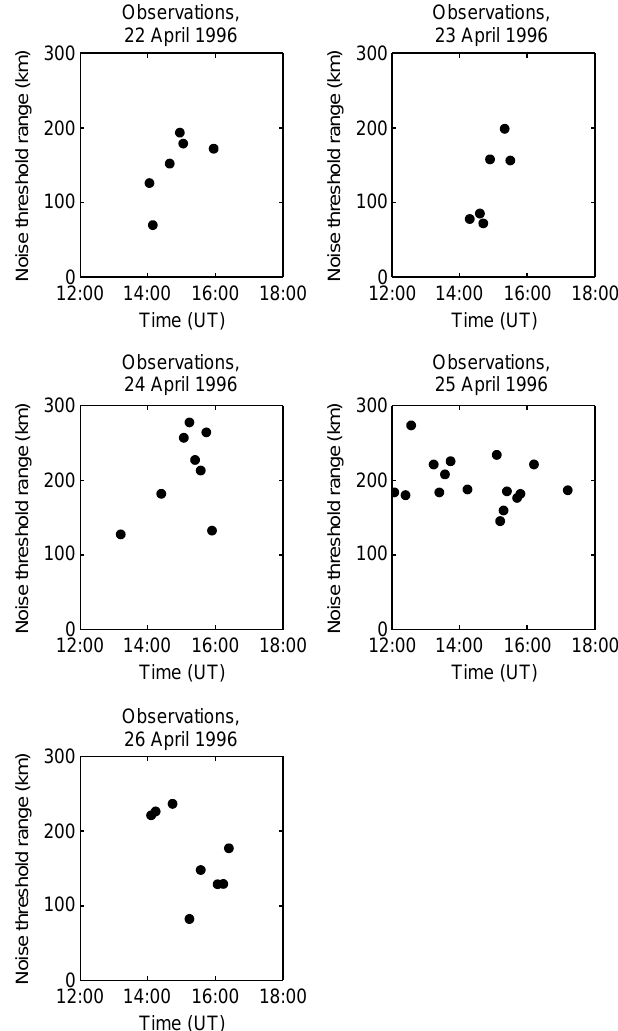
Fig. 9. Observations for 22–26 April 1996. The noise threshold range, a measure of where artificial scatter is observed above the noise level, plotted as a function of UT